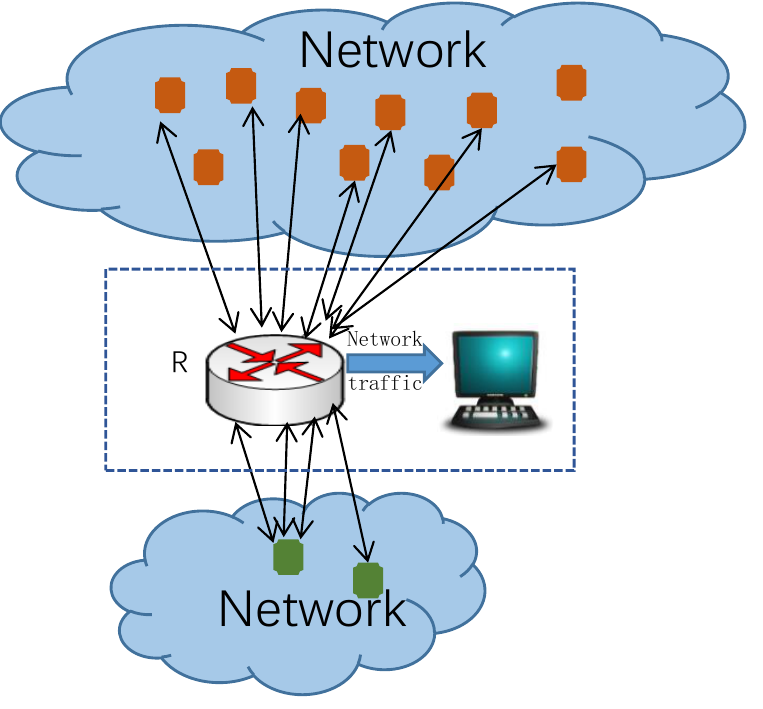
Figure 1. The observation node on network